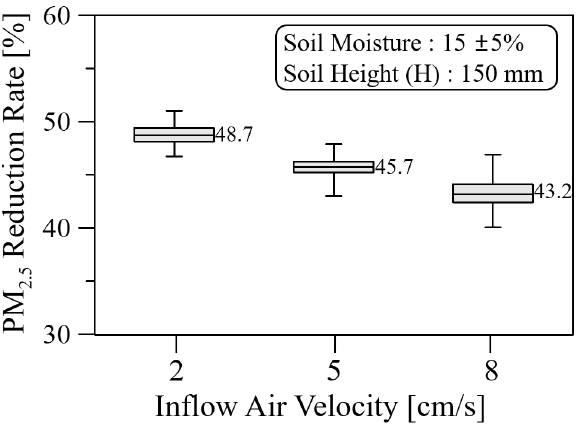
Figure 9. PM 2.5 reduction rate with respect to inflow air velocity for the soil height and moisture of 150 mm and 15 ± 5%, respectively.